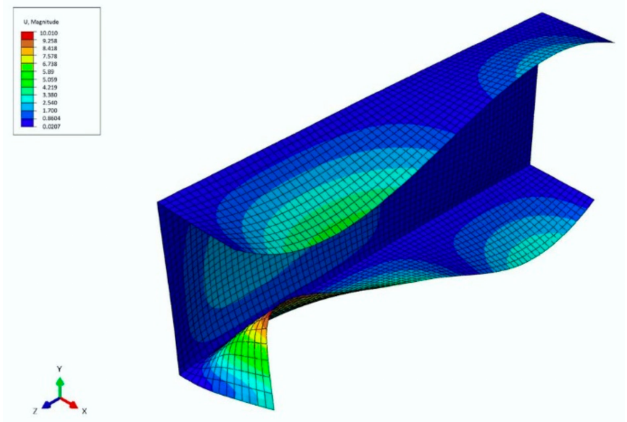
Figure 10. Collapse mode for the channel of lengths L = 210 mm/250 mm in the ultimate